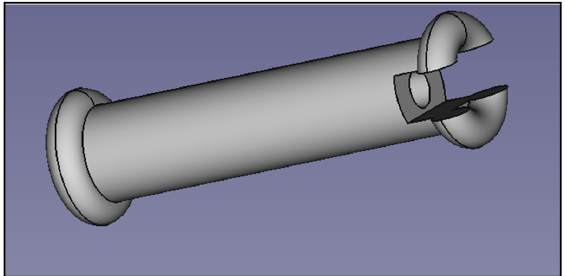
Figure 8. NinjaFlex slit design.